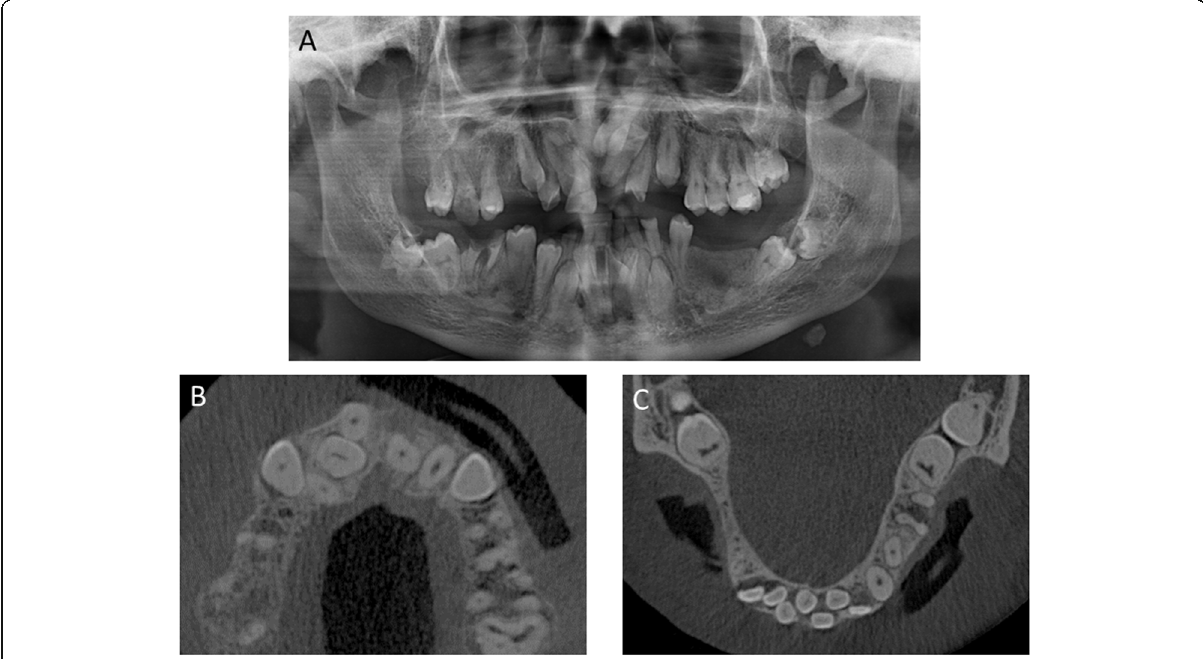
Fig. 2 a The OPG and b , c excerpts from the CBCT scan. Typical CCD findings can be seen: retained teeth, jaw malposition, and bony variations. OPG, orthopantomogram; CBCT, cone-beam computed tomography; CCD, cleidocranial